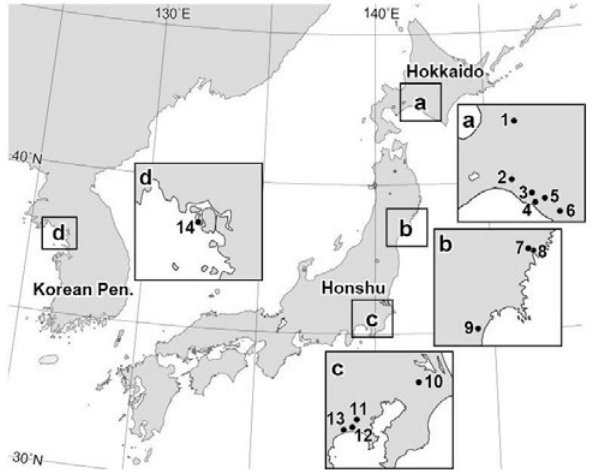
Fig. 1. Collection localities of the house mice examined in this study. Locality code numbers correspond to those in Table